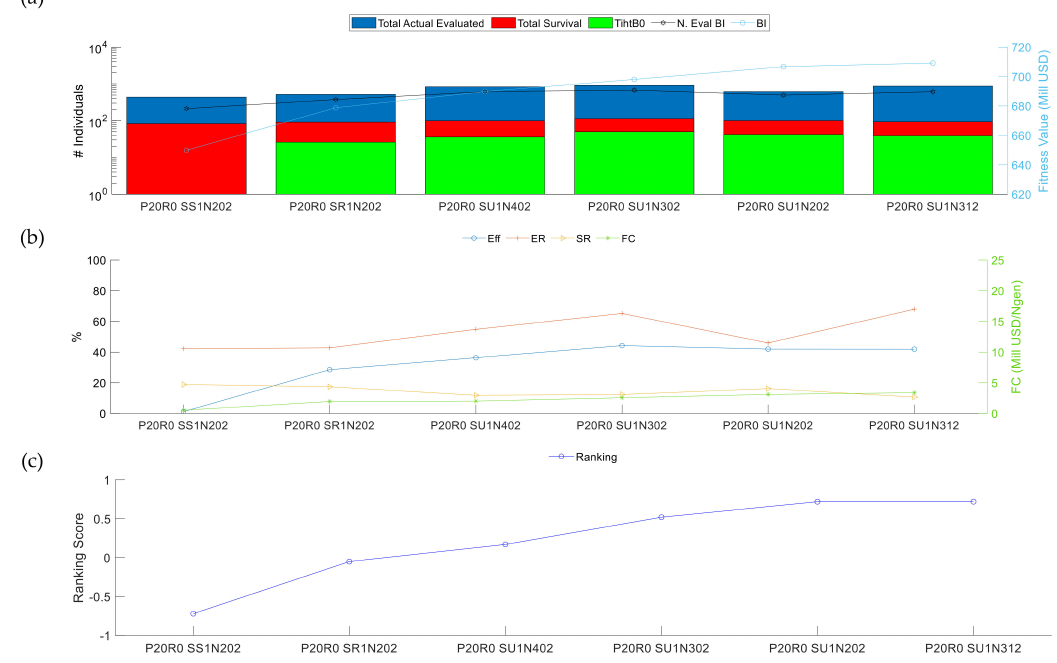
Figure 21. Summary of the performance indicators for analysis I, Section 2. ( a ) shows variables of KPI 3,4 and 5 in bar chart, KPI 1 and variable of KPI 7 in line chart, ( b ) shows KPI 3,4,5 and 6 in line chart, ( c ) shows the ranking score based on Table